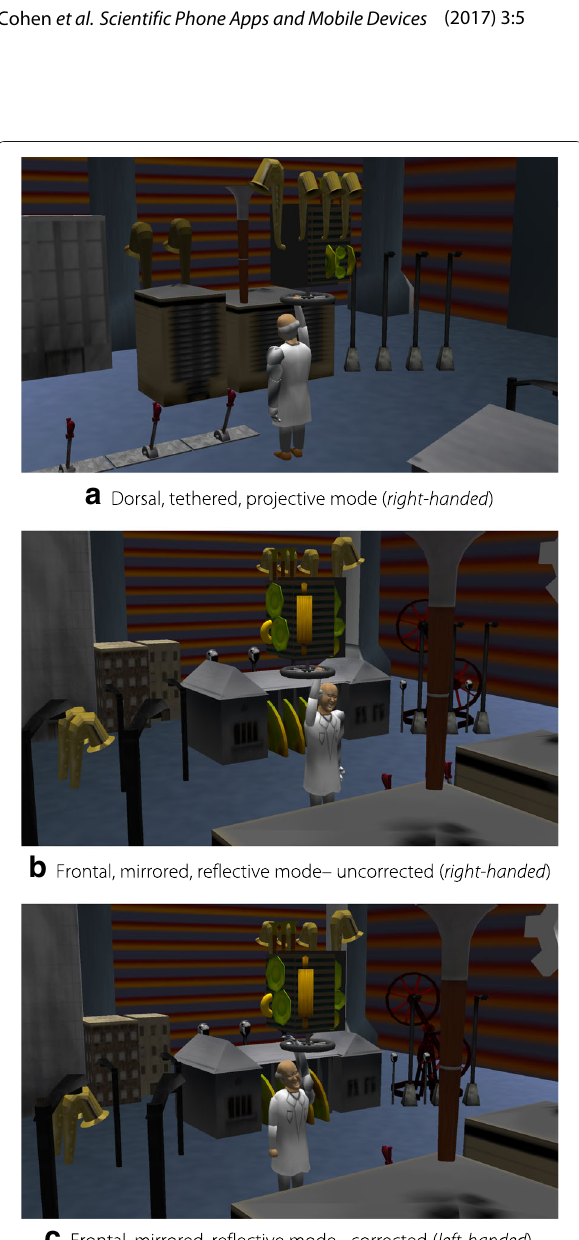
Fig. 15 Continuous spin-around gesture, without and with hand-switching: Ambidexterous display of unidexterous control by context-aware puppet